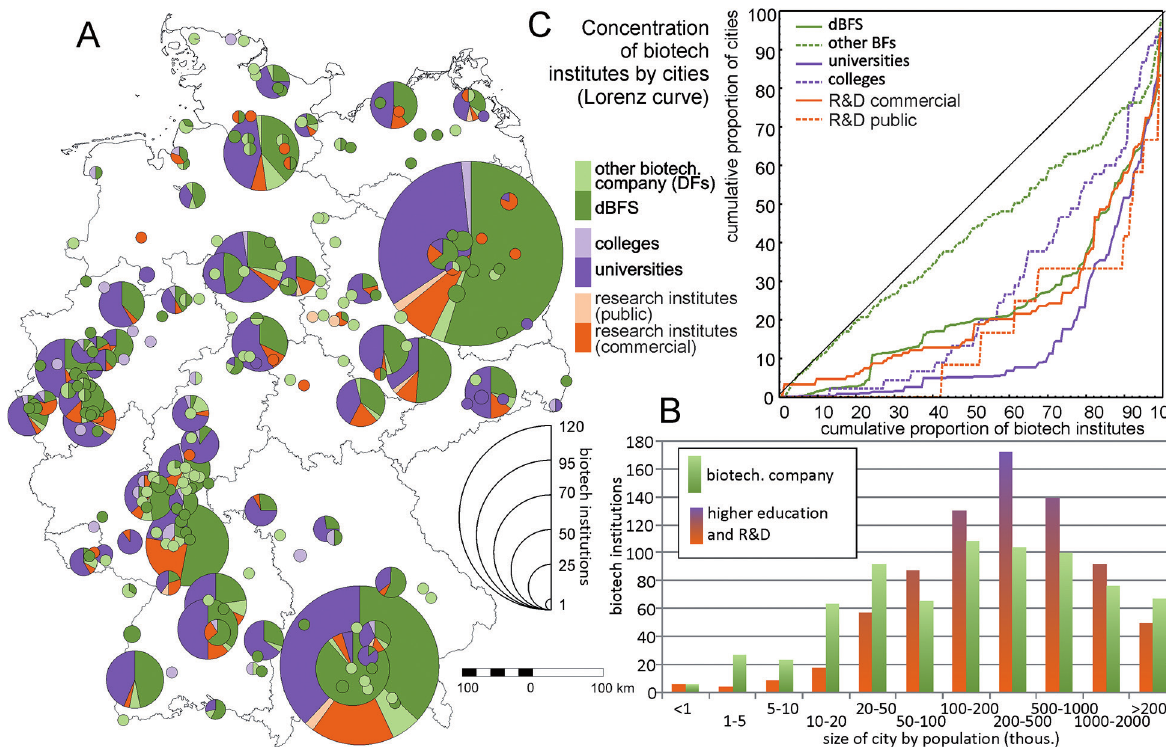
Fig. 11. Distribution of cities and biotech institutions (A), city size structure (B), and concentration (C) of biotech institutions in Germany, 2013 Source: own calculations based on the Internet portal